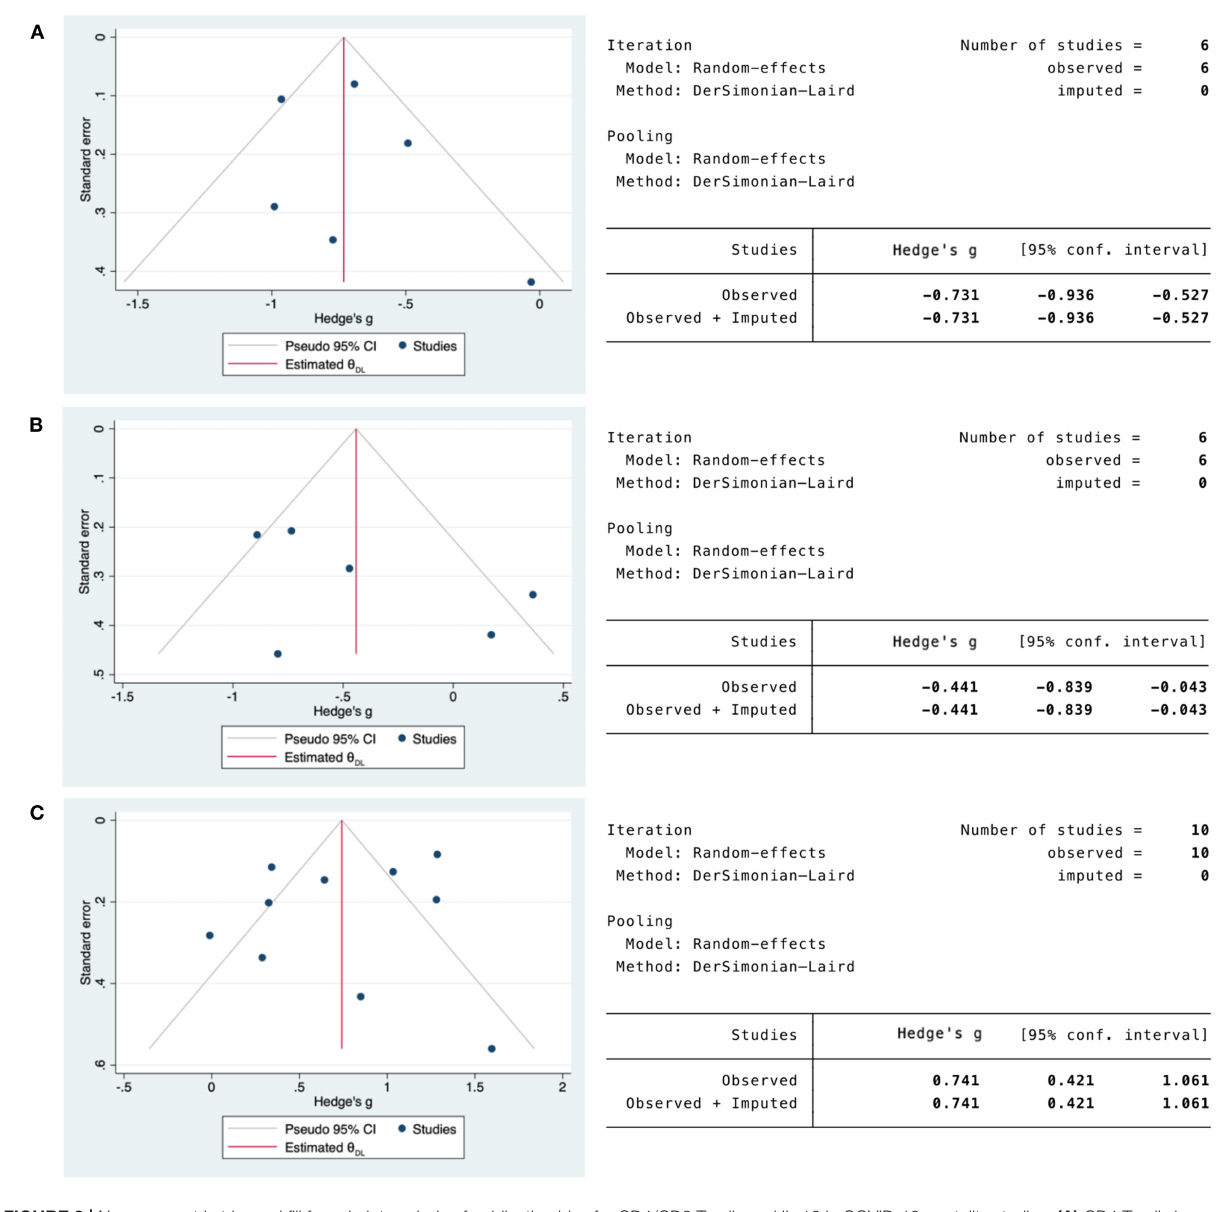
disease progression or mortality in the present time and the